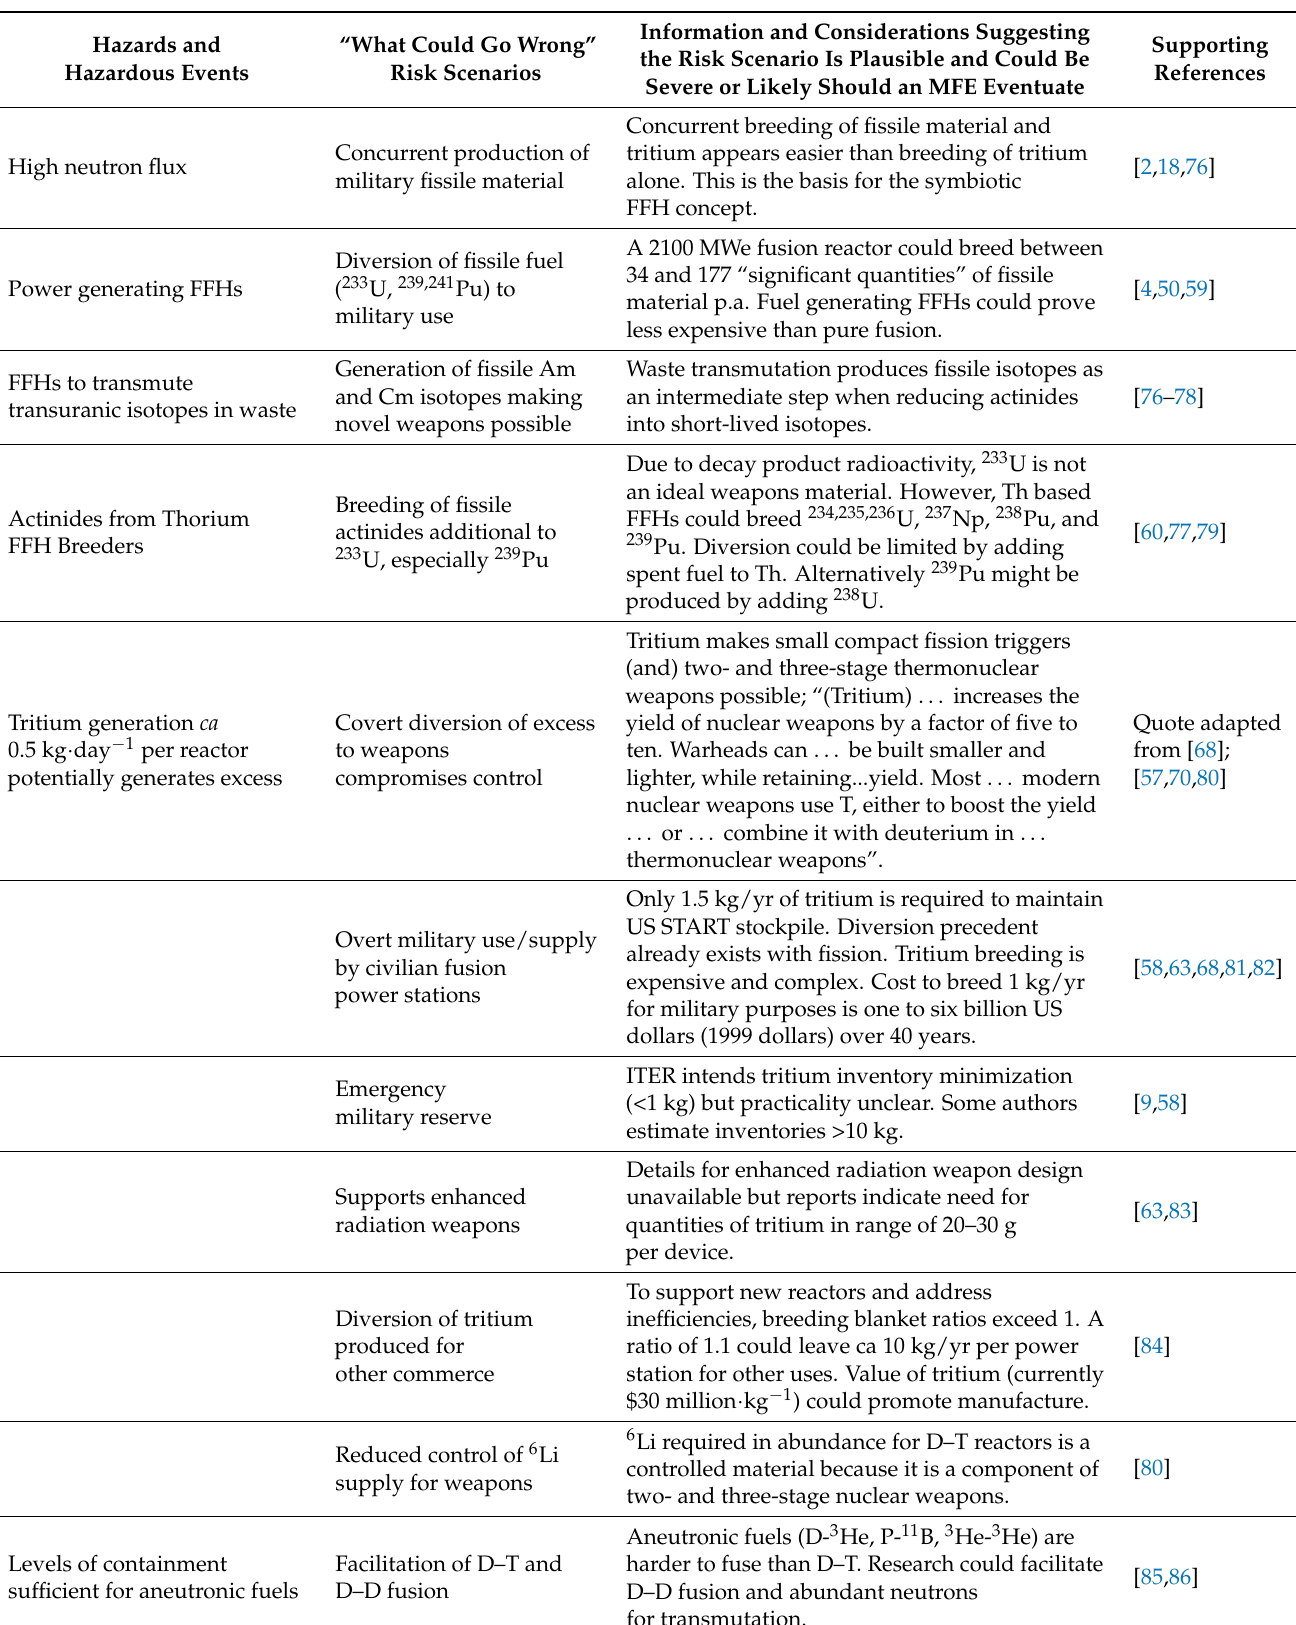
Table 2. Hazards, risks, severity, and